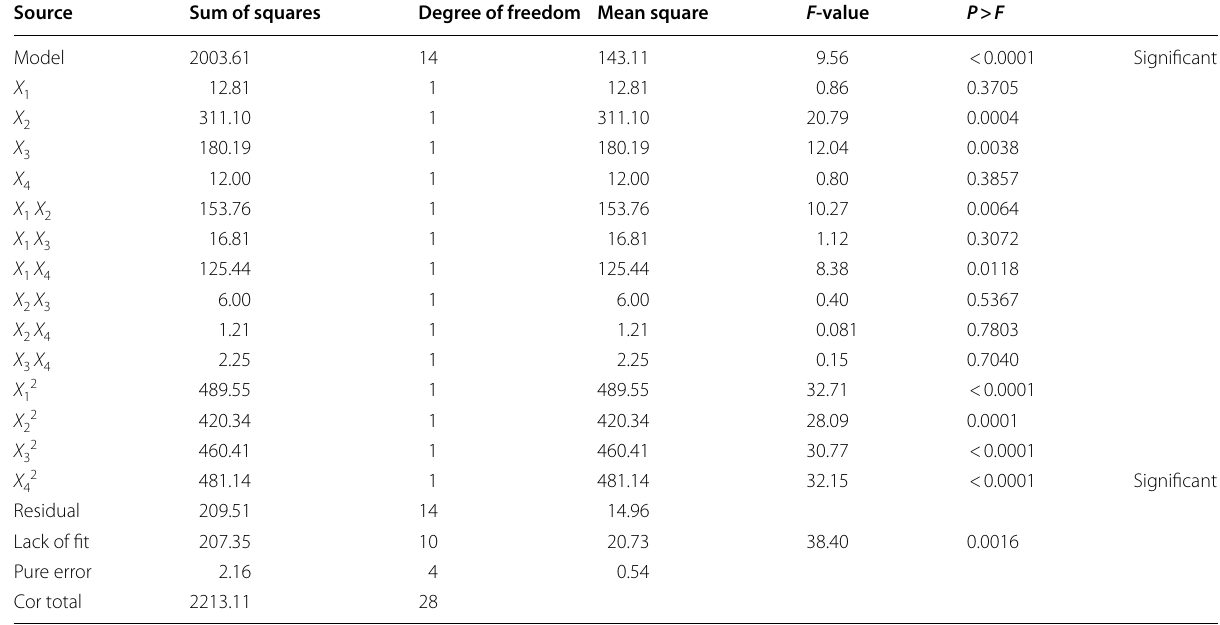
Table 4 Analysis of variance for the regression equation of the lignin extraction yield Source Sum of